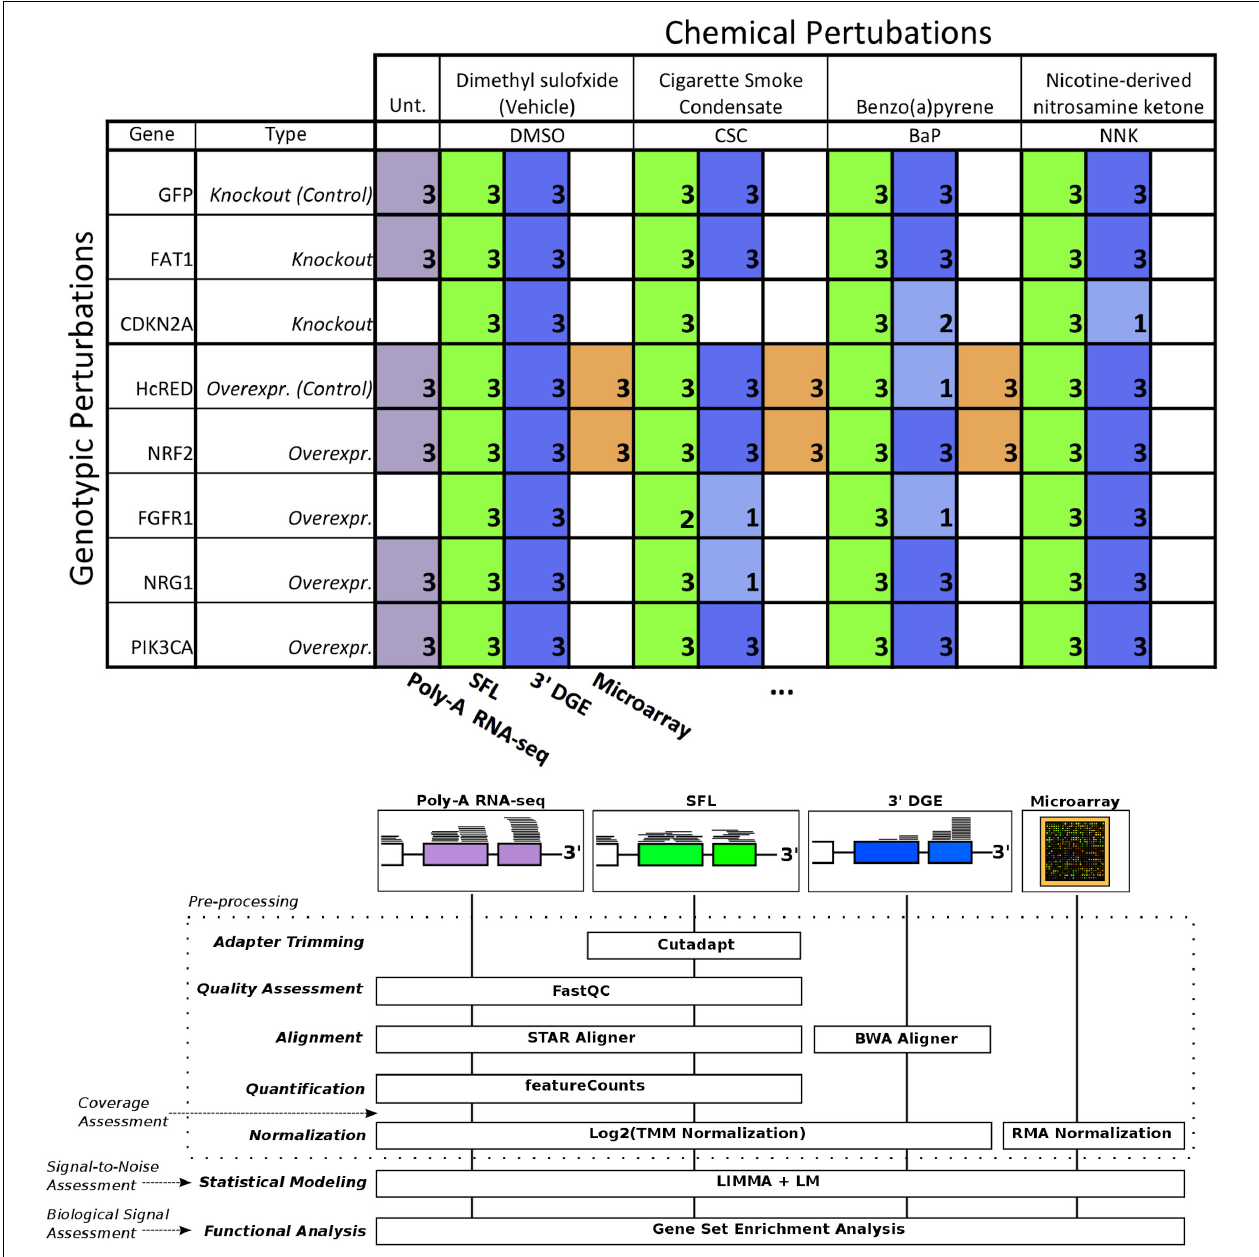
FIGURE 1 | Design of cross-platform experiments and high-throughput data processing. Schematic of the number of each pair of genotypic and chemical perturbations, as well as a summary of preprocessing methods used to quantify gene-level expression for each platform. Note that “Unt.” is an abbreviation of “untreated,” denoting that the RNA-seq samples used in this experiment did not receive chemical perturbations. Numbers in each box represent biological replicates of each condition. The color scheme for each platform is consistent throughout this report.